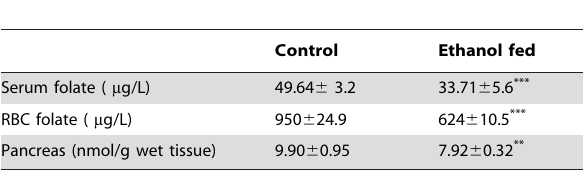
Table 1. Folate levels in serum, RBCs and pancreatic tissue of control and ethanol fed